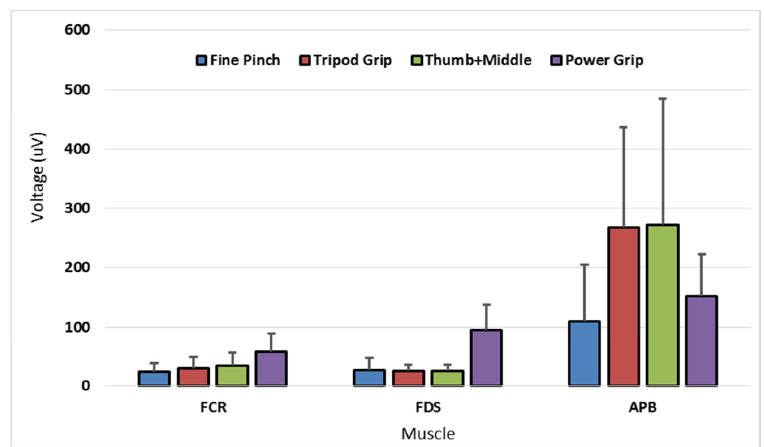
Fig. 7: Mean of the absolute value of EMG for 3 muscles for different grip types (fine, tripod, grip with thumb and middle fingers and power grip) for 100% MVC. Error bars represent standard deviation across the 5 subjects.